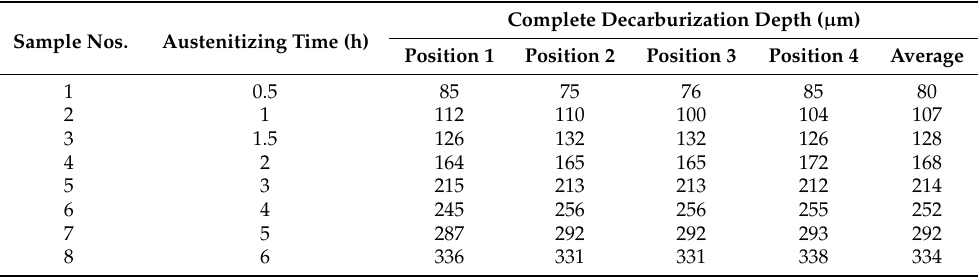
Table 2. Complete decarburization depths estimated based on metallographic analysis of all samples with martensitic core